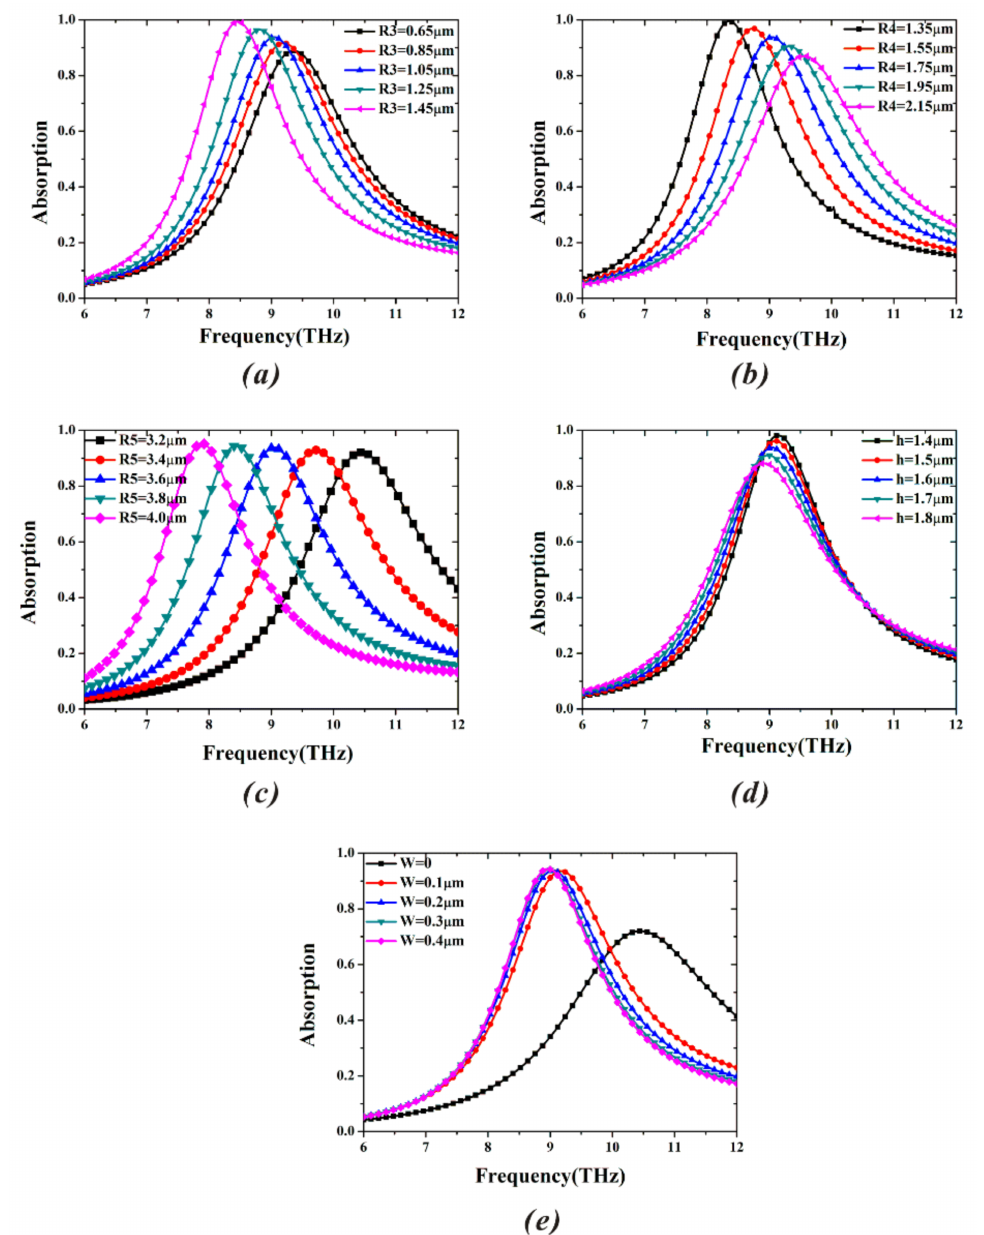
Figure 3. Simulated absorption spectra of the proposed MA under different geometric parameters: ( a ) the inner radius ( R3 ) of sixteen circular sector at the center ( R1 = 0.45 µ m, R4 = 1.75 µ m, R5 = 3.6 µ m, h = 1.6 µ m, and W = 0.2 µ m), ( b ) the inner radius ( R4 ) of sixteen circular sector ( R1 = 0.45 µ m, R3 = 1.05 µ m, R5 = 3.6 µ m, h = 1.6 µ m, and W = 0.2 µ m), ( c ) the outer radius ( R5 ) of sixteen circular sector ( R1 = 0.45 µ m, R3 = 1.05 µ m, R4 = 1.75 µ m, h = 1.6 µ m, and W = 0.2 µ m), ( d ) the thickness ( h ) of dielectric layer ( R1 = 0.45 µ m, R3 = 1.05 µ m, R4 = 1.75 µ m, R5 = 3.6 µ m, and W = 0.2 µ m), and ( e ) the width ( w ) of gap in the sixteen circular sector ( R1 = 0.45 µ m, R3 = 1.05 µ m, R4 = 1.75 µ m, R5 = 3.6 µ m, and h = 1.6 µ